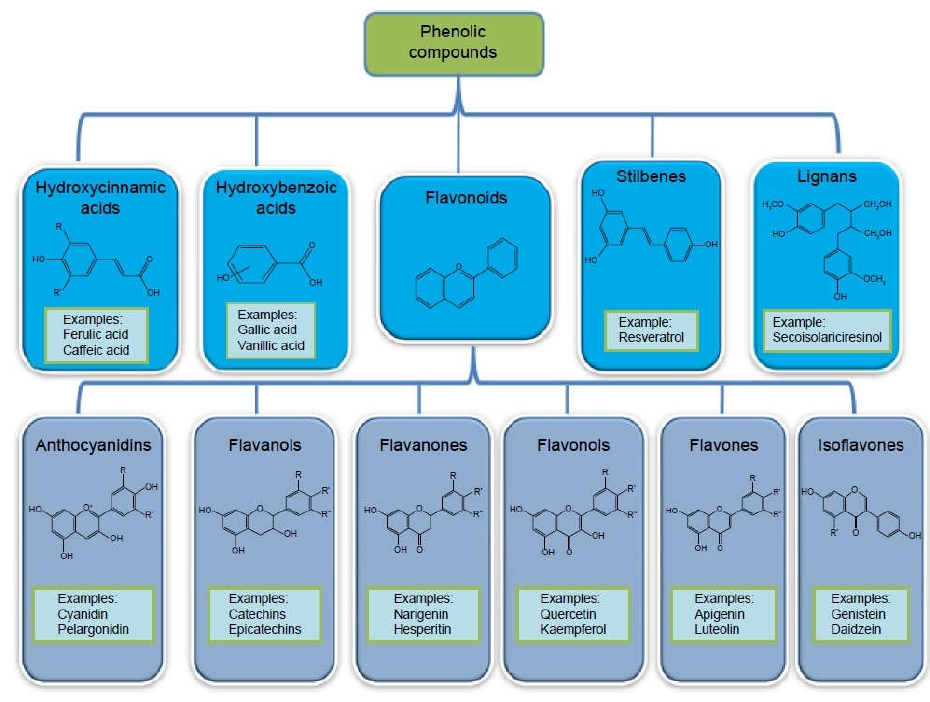
Figure 2. Phenolic Compounds.